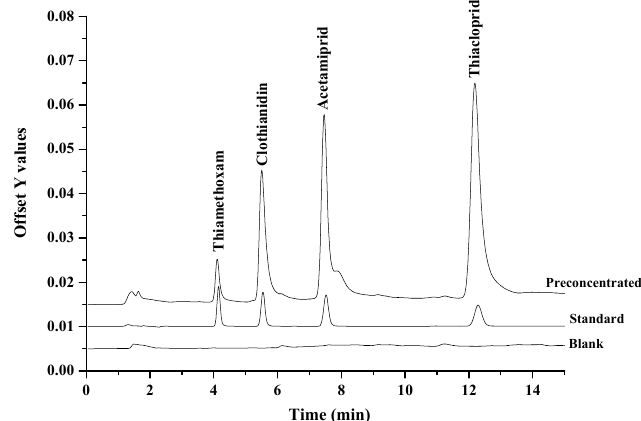
Figure 5. The overlaid chromatograms of the studied neonicotinoid insecticides obtained from blank, direct high-performance liquid chromatography (HPLC) and preconcentrated by the proposed microextraction method (sample volume 10 mL; 0.1 µ g · mL − 1 of each neonicotinoid